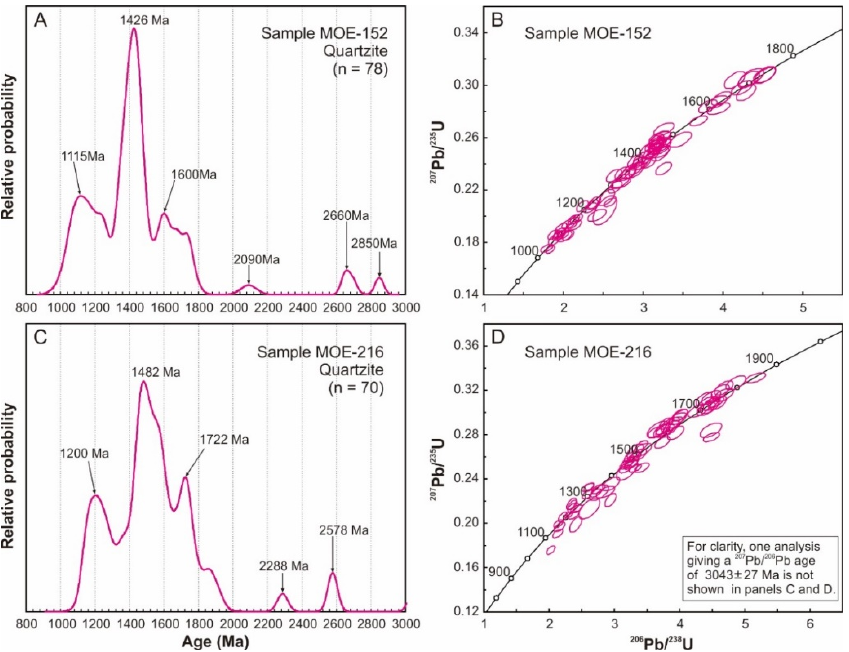
Figure 7. Detrital zircon age-relative probability curves ( left ) and concordia plots ( right ) for two quartzite samples MOE-152 ( A , B ) and MOE-216 ( C , D ) from the Ereendavaa terrane in NE Mongolia Sample MOE-216 : This is a quartzite sample collected from the basement rocks exposed at ca. 55